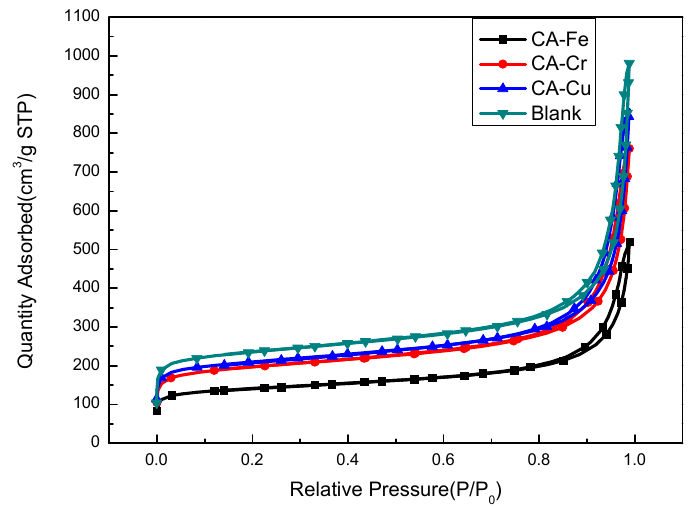
Figure 4 . Nitrogen adsorption-desorption isotherms of the CA-X and the blank.